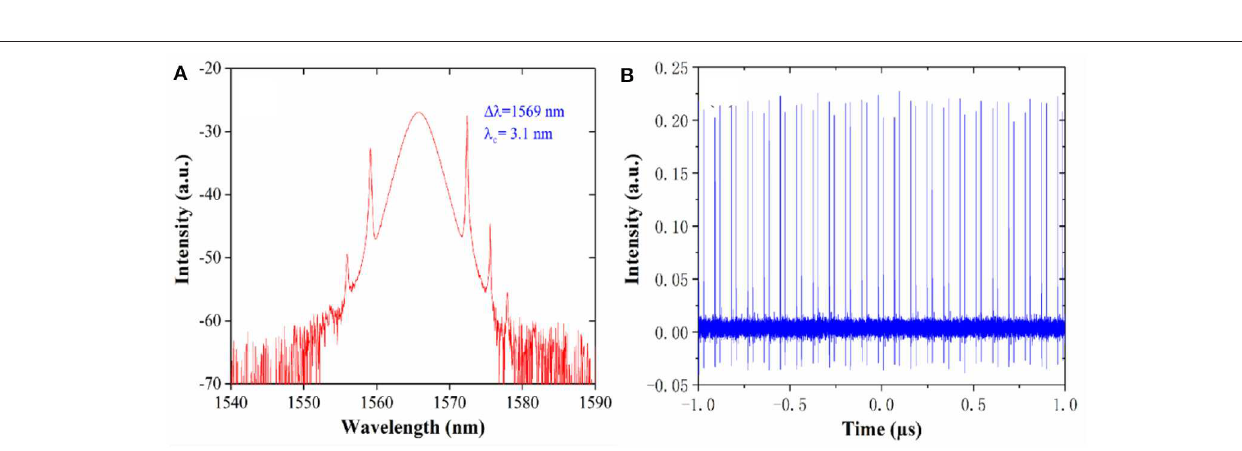
FIGURE 5 | (A) Output spectrum. (B) Pulse